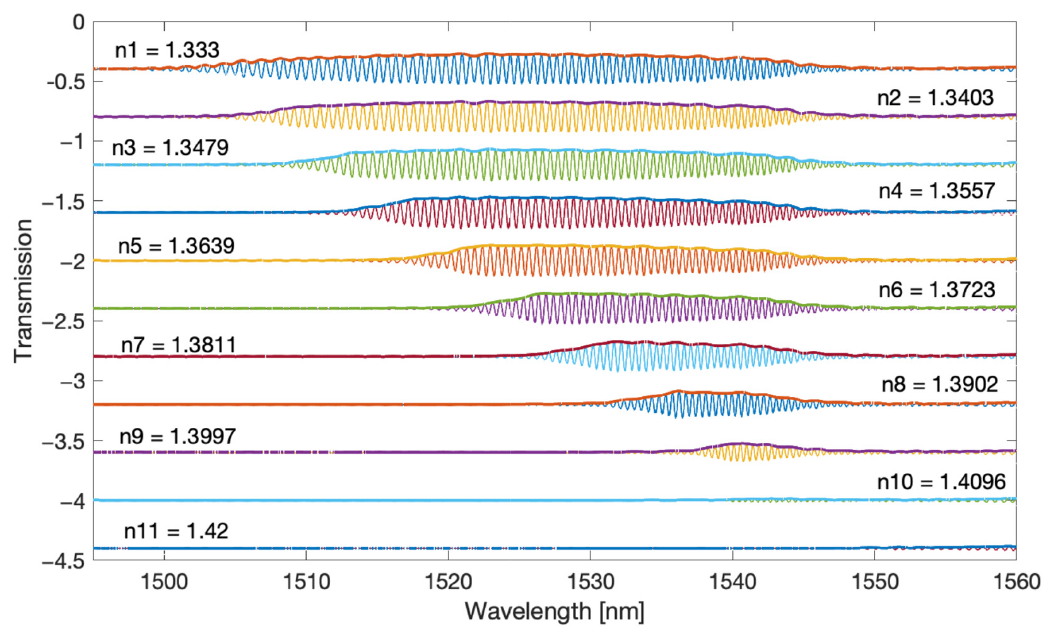
Figure 6. Envelope calculated by the Hilbert transform method for the main frequency band.